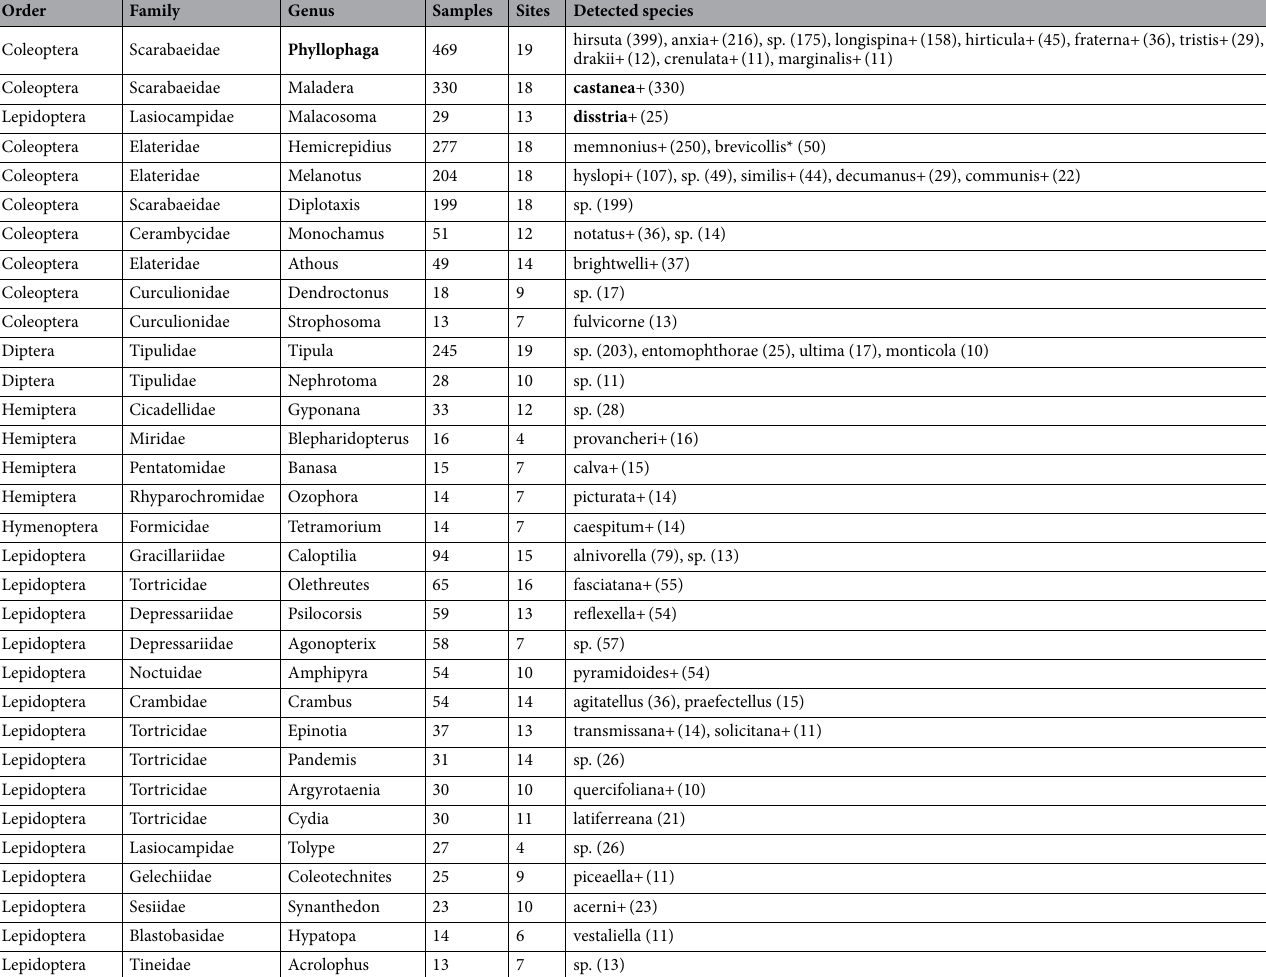
Table 2. Genera detected in bat guano. Pest taxa listed by the US Forest Service or US Department of Agriculture were matched at genus level to sequence variants classified in bat guano. The exact species matches are highlighted in bold. The most prevalent pest genera, Phyllophaga , is listed by the US Forest Service as a complex group, thus no single species is highlighted. Remaining taxa shared common genus labels only but were not exact species matches. Taxa endemic to New Hampshire are denoted (+) or endemic to other New England states as (*). Numbers of samples detected for species within shared genus listed in